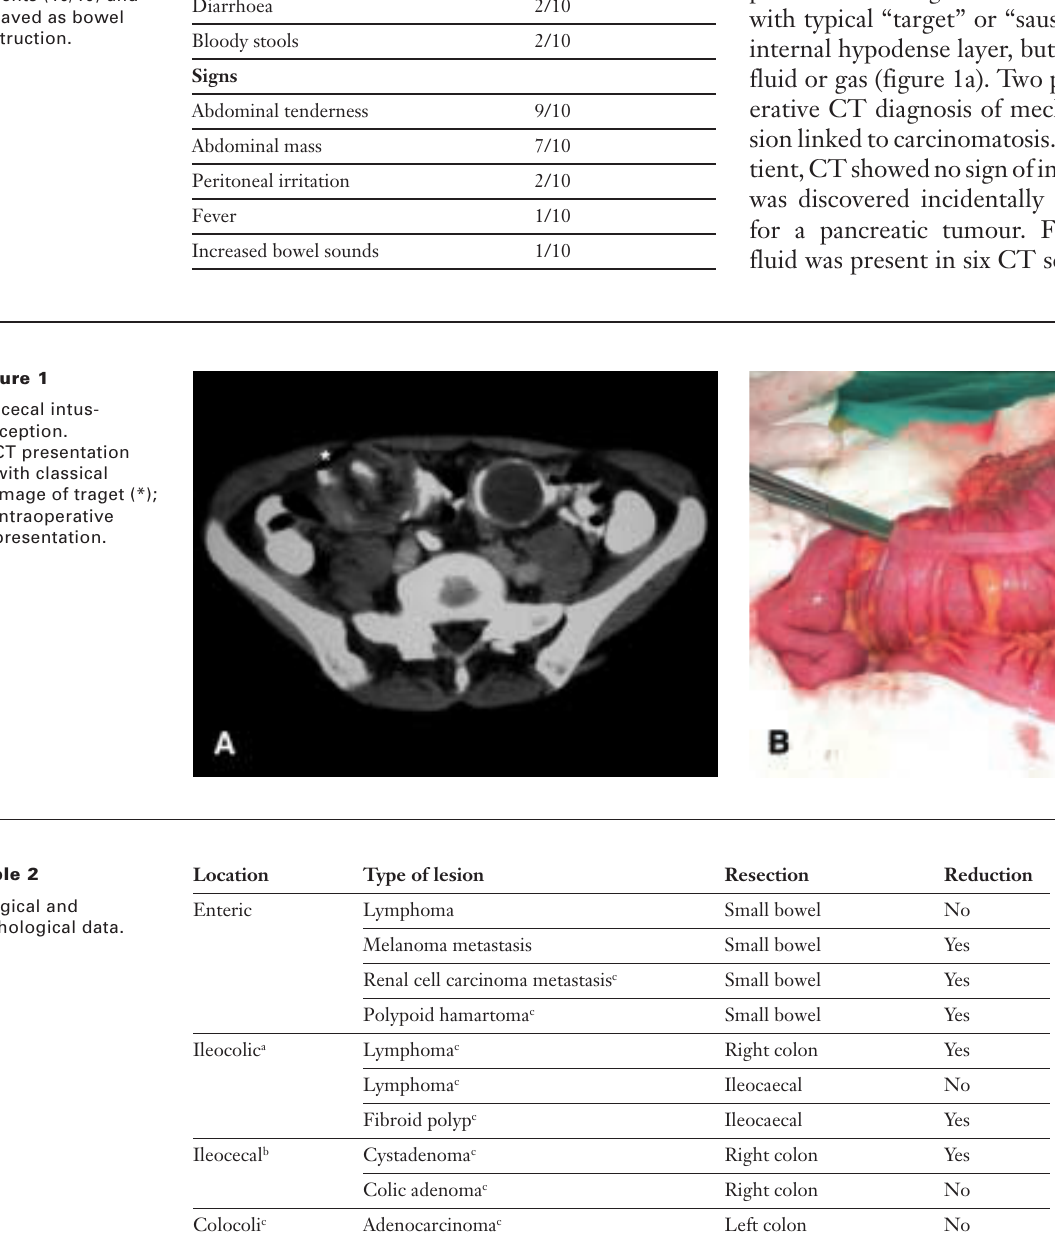
Clinical presentation: Intussusception was symptomatic in all patients (10/10) and behaved as bowel obstruction.